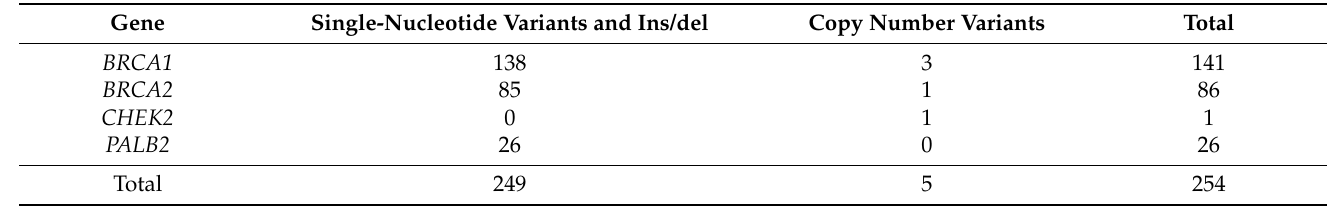
Table 1. Variants detected by the tested method in each of the analyzed genes. Gene Single-Nucleotide Variants and Ins/del